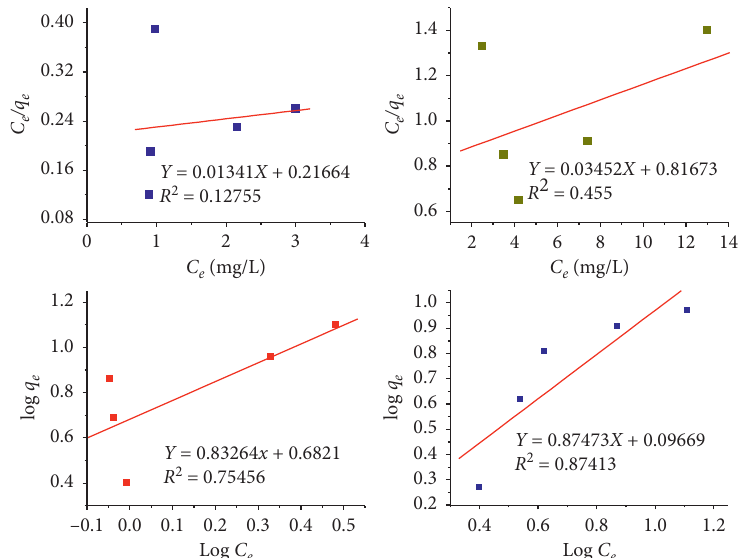
Figure 12: Langmuir isotherm (a) for ALAPW and (b) for RLAPW and Freundlich isotherm (c) for ALAPW and (d) RLAPW. Table 4: Isotherm parameters for the adsorption of MG dye onto ALAPW and RLAPW. Isotherm models